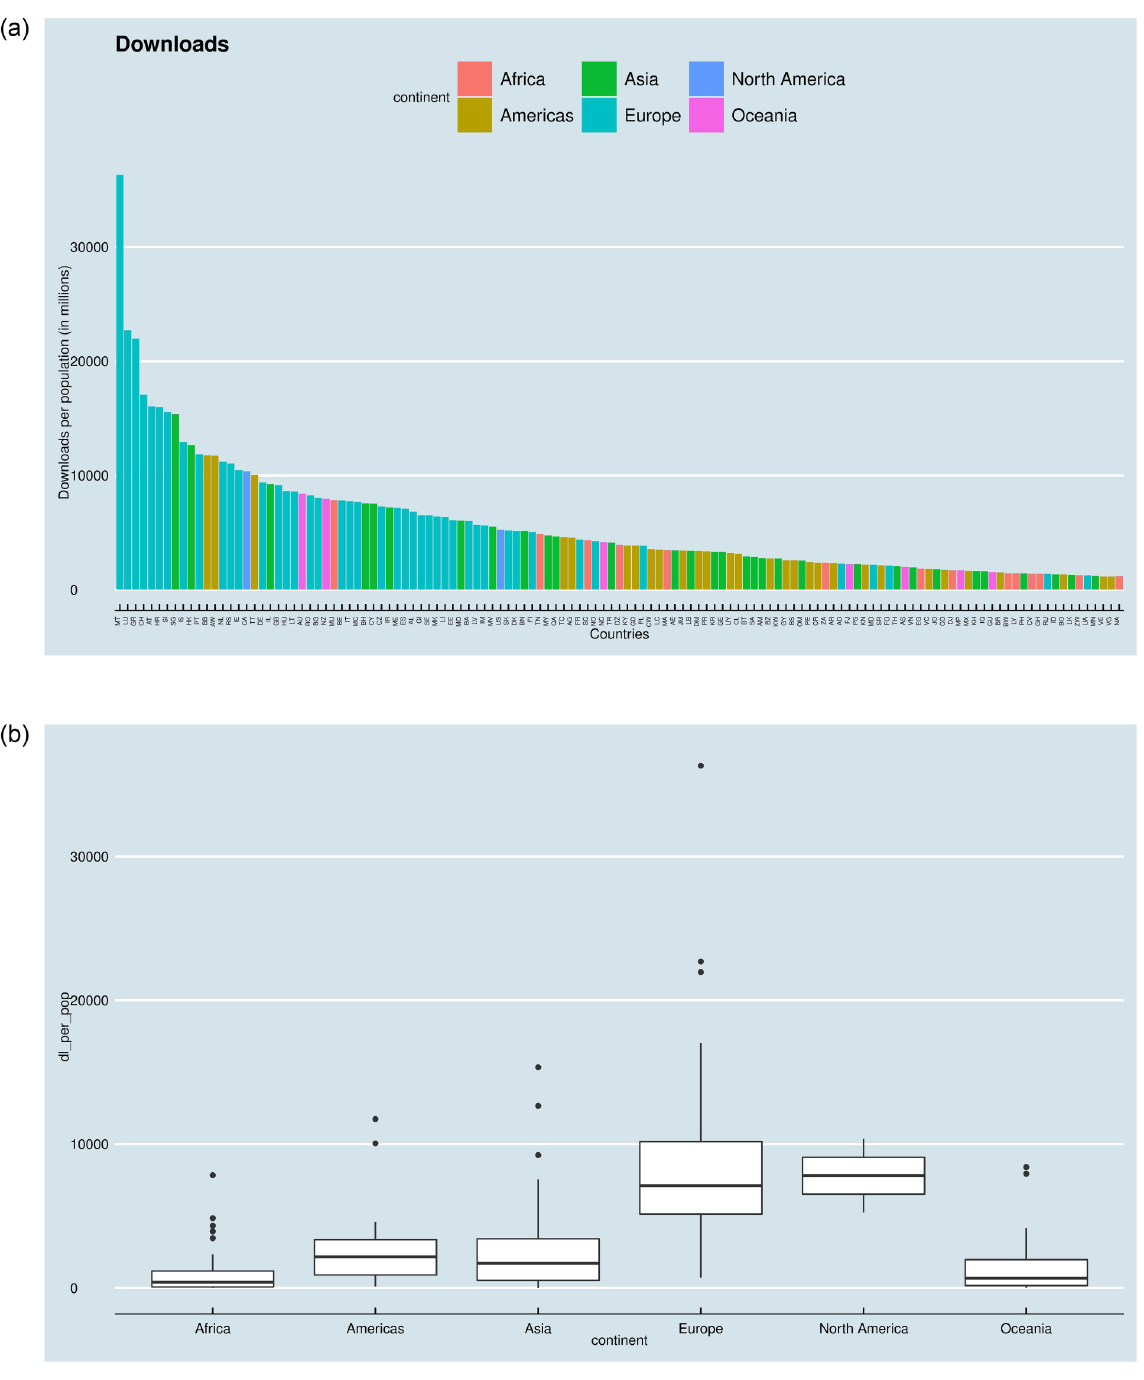
Fig 3. a, b. Country-level and regional variance of the dependent